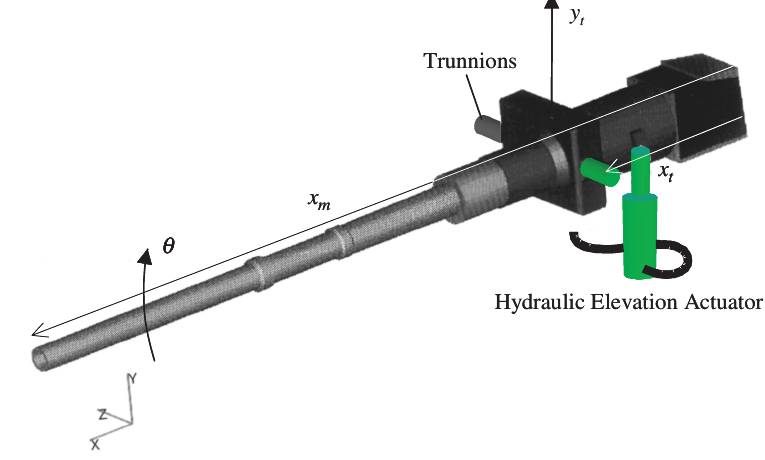
Fig. 2. Rigid-body motion of the barrel due to terrain and actuator